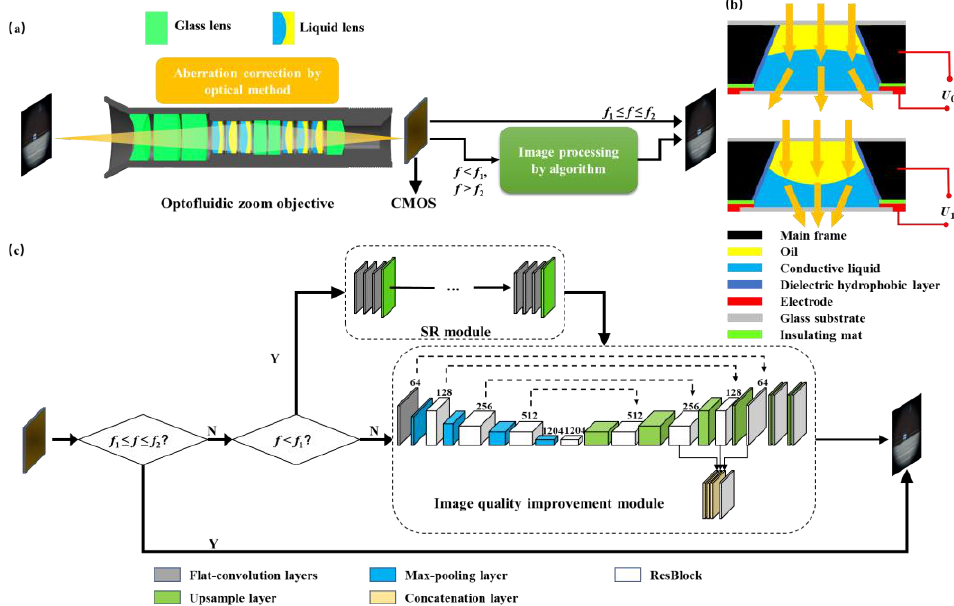
Figure 1. Schematic cross-sectional structure and the principle of the proposed zoom system. ( a ) Structure of the proposed zoom system. ( b ) Structure and principle of the electrowetting lens. U 1 and U 0 are different applied voltages. The yellow arrows represent the direction of light propagation. ( c ) Flow chart of image processing.